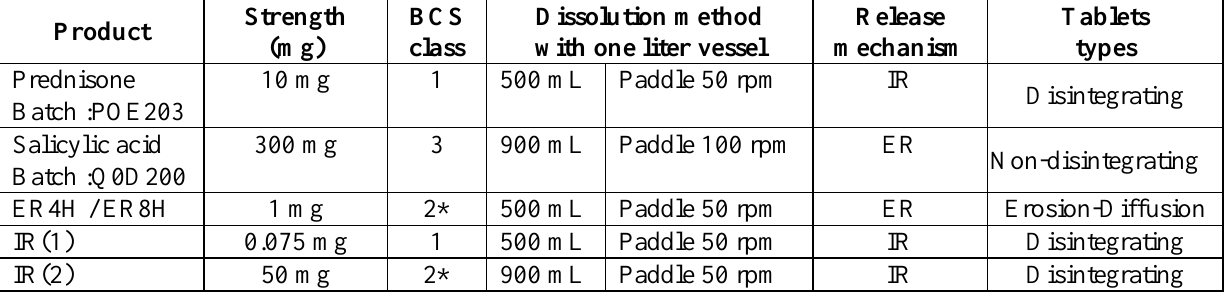
Table 2. Overview of the tablets and release mechanisms tested using both dissolution methods.